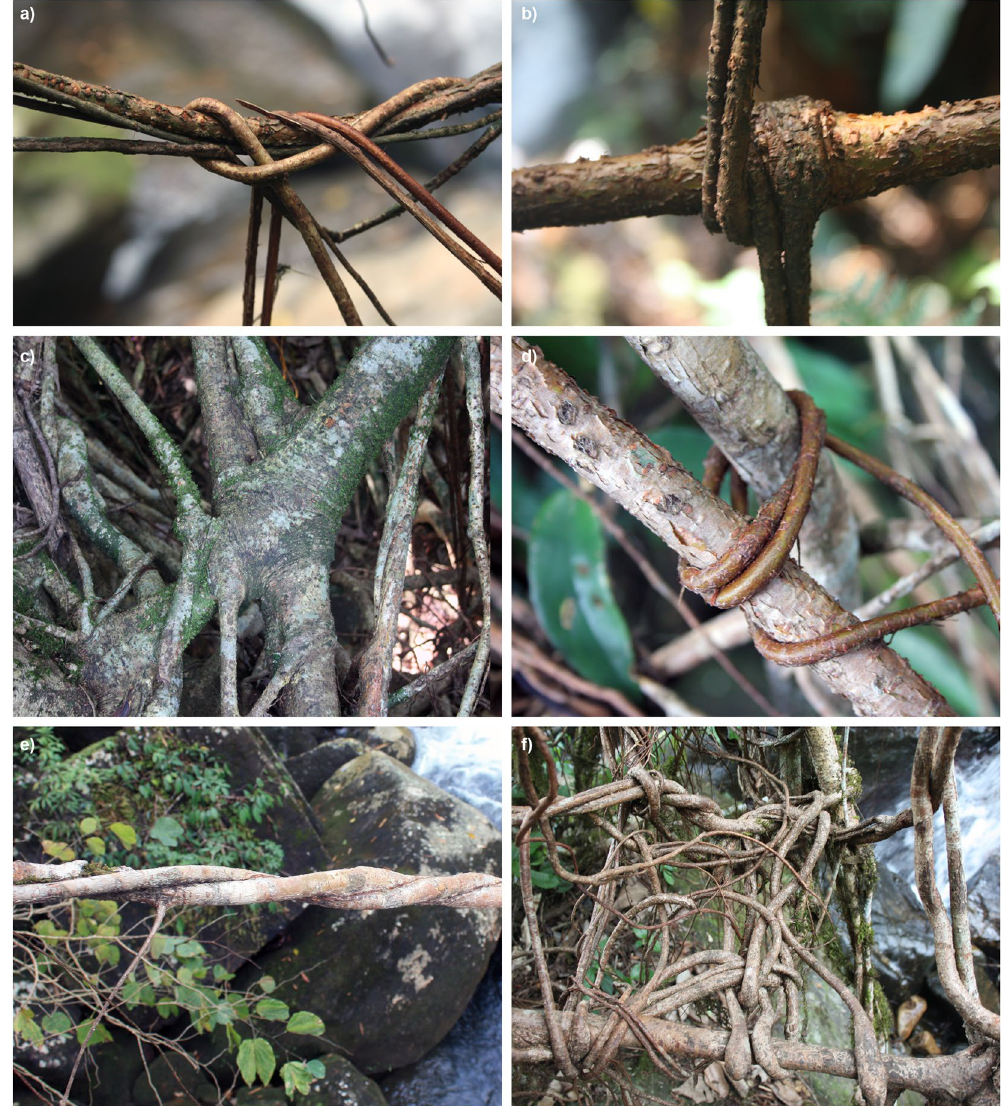
Figure 9. ( a ) Man-made inosculations in LRBs. ( a ) young nodal connection, ( b ) a similar connection after tightening and the beginning of inosculation, ( c ) a fully established inosculated node, ( d ) a young root used to tie together two older ones, ( e ) a typical example of a twisted linear connection with first signs of inosculation, ( f ) a structure with thickened roots showing no